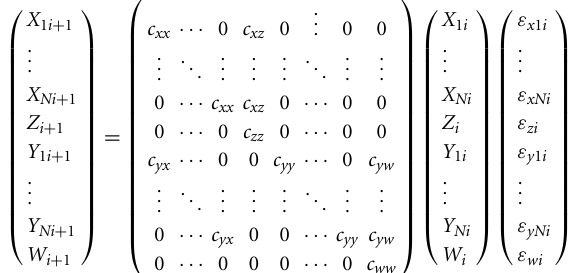
combinations. (D) Another example of causal graph where spatial aggregation is present in the recording of the signals from the two areas. The system is again generated as a multivariate autoregressive process with identical connections from Z to each X k , identical from W to each Y k , and identical from each X k to each Y k (see the main text for details). (E) The Granger causality measure T < X > → < Y > as a function of the coefficient c yw and the number of processes N . (F) The relative changes (cid:6) T (cid:4) (Equation 16) of the Granger causality measure as a function of the coefficient c yx and the number of processes N